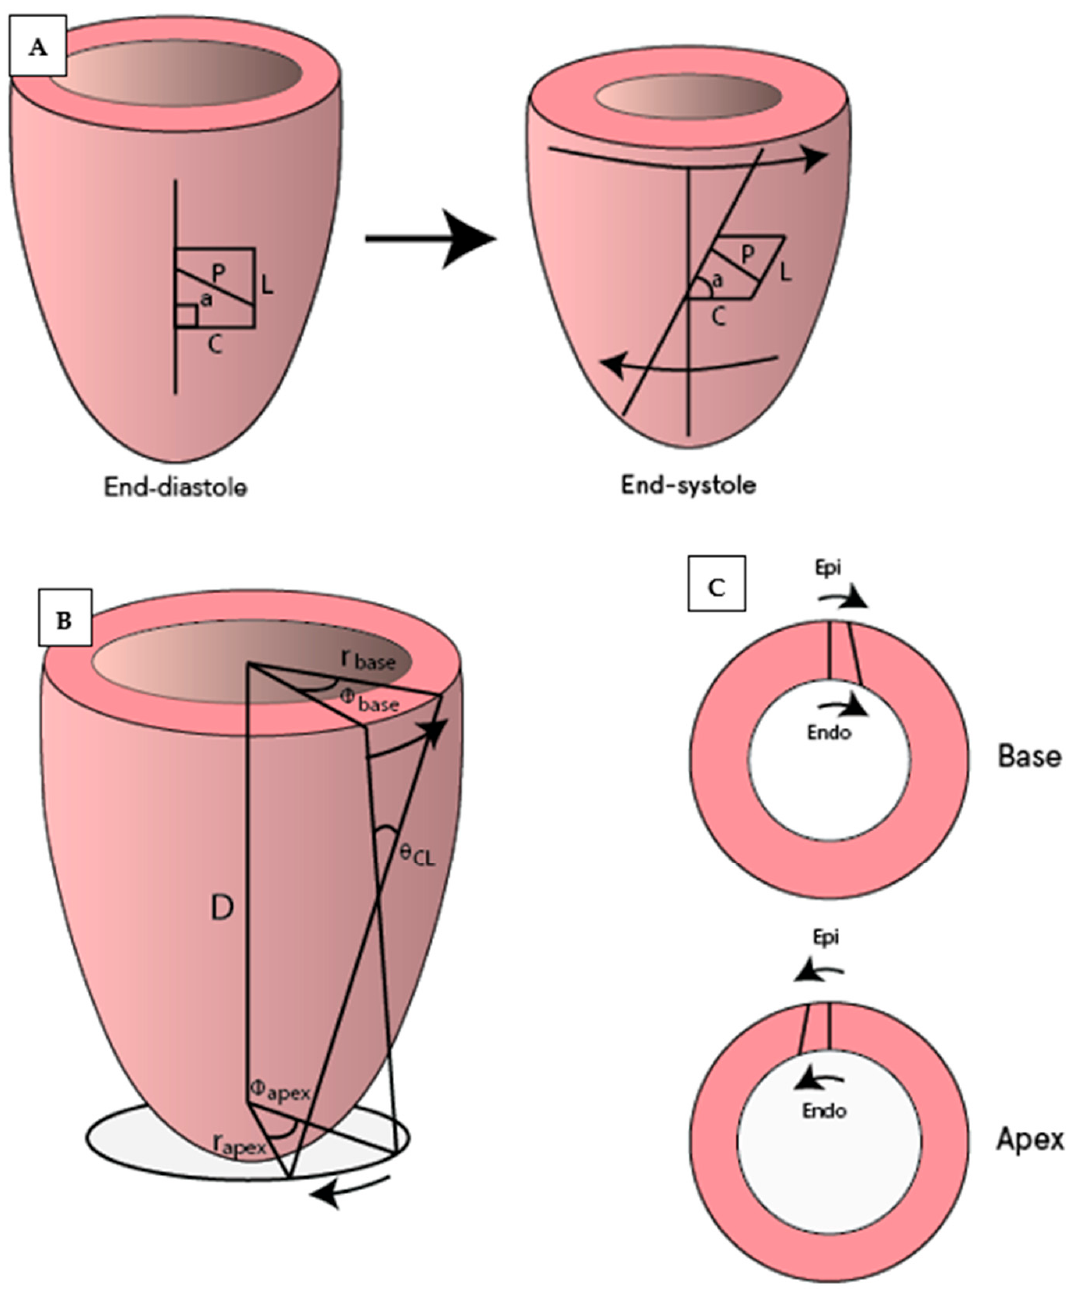
Figure 3. Illustration of commonly used CMR tagging measurements. ( A ) Circumferential ( C ) and longitudinal strain (L), which also allows for measurements of strain rates and shear strain (difference in strain between two locations such as circumferential-longitudinal or circumferential-radial). Measurement of diastolic rotation (a) and untwisting (difference in rotation between defined basal and apical slices; in degrees) and their corresponding rates (temporal changes). ( B ) The torsion shear angle θ CL = , the change in angle of longitudinal tag lines from the base to the apex on the surface of the heart [23]. ( C ) Circumferential-radial strain.